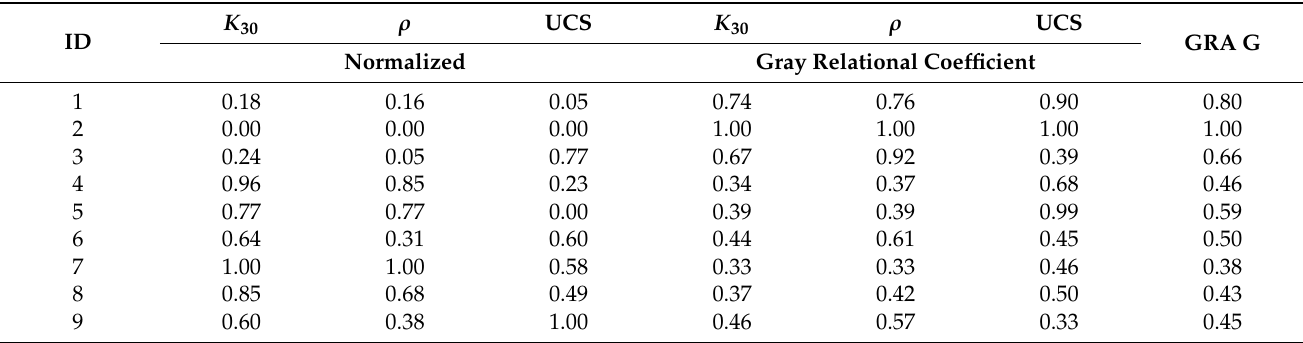
Table 4. Grey rational analysis.